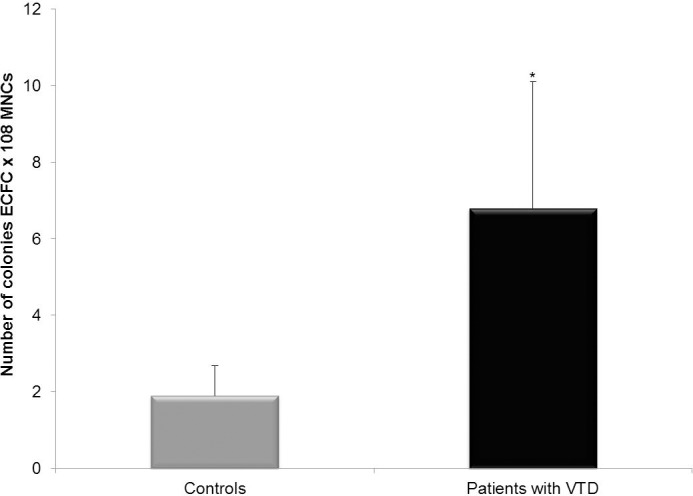
Frequency of ECFCs obtained from peripheral blood of controls and patients with VTD.This figure shows the number of ECFC colonies obtained from peripheral blood of controls and patients with VTD per 108 MNCs seeded in culture plates. Results are expressed as mean ± standard deviation of 16 independent samples in each case. *P = 0.001.